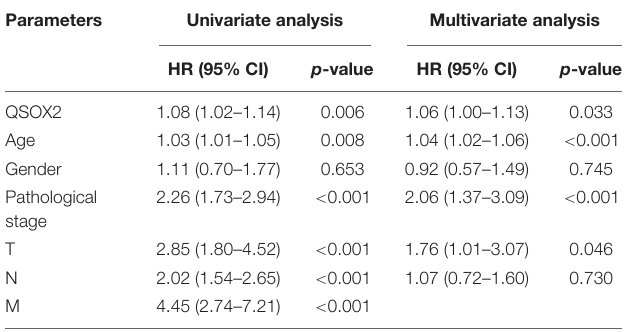
TABLE 6 | Univariate and multivariate Cox proportional hazards analysis of overall survival (OS) in CRC patients based on TCGA cohort. Parameters Univariate analysis Multivariate analysis